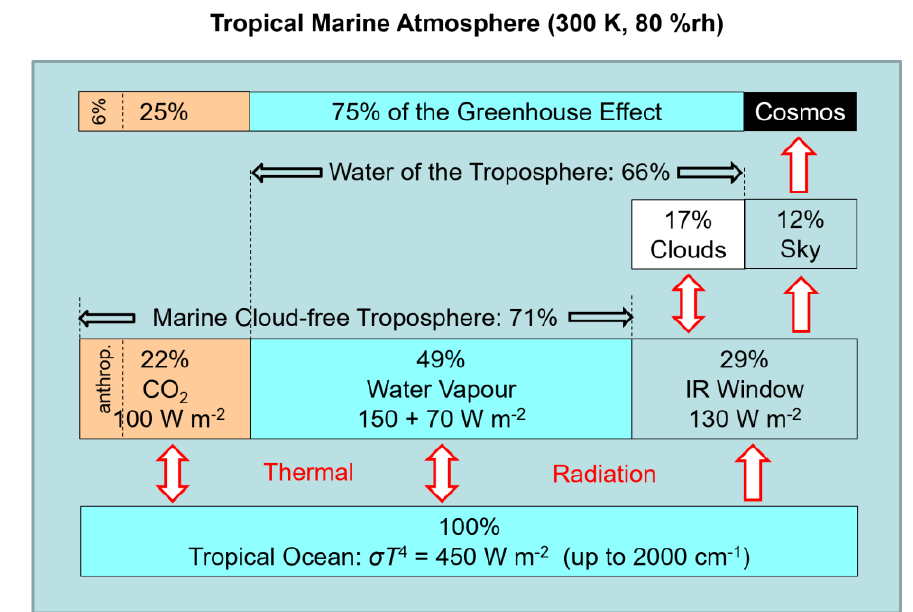
Figure 6. Conceptual spectral-band model of the tropical marine greenhouse effect. The thermal radiation at 300 K and 80 %rh amounts to 450 W m −2 (lowest box). According to Table 1, 100 W m −2 thereof are absorbed by CO 2 in band B (anthropogenic part 25 W m −2 ) and (150 + 70) W m −2 = 220 W m −2 by water vapour in bands A and D. The rest of 130 W m −2 in the radiation window D is blocked to 60 % by clouds and only the remaining 130 W m −2 × 40 % = 52 W m −2 are directly emitted from the sea surface to the cosmic space. Anthropogenic CO 2 has narrowed the window by 25 W m −2 and, therefore, the emission without clouds by 10 W m −2 . Water in the form of vapour and clouds is responsible for 75 % of the total greenhouse effect in the